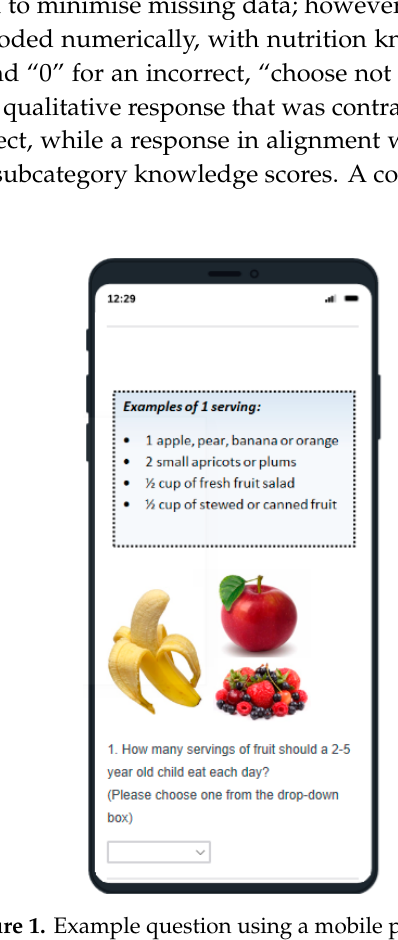
Figure 1. Example question using a mobile phone view.